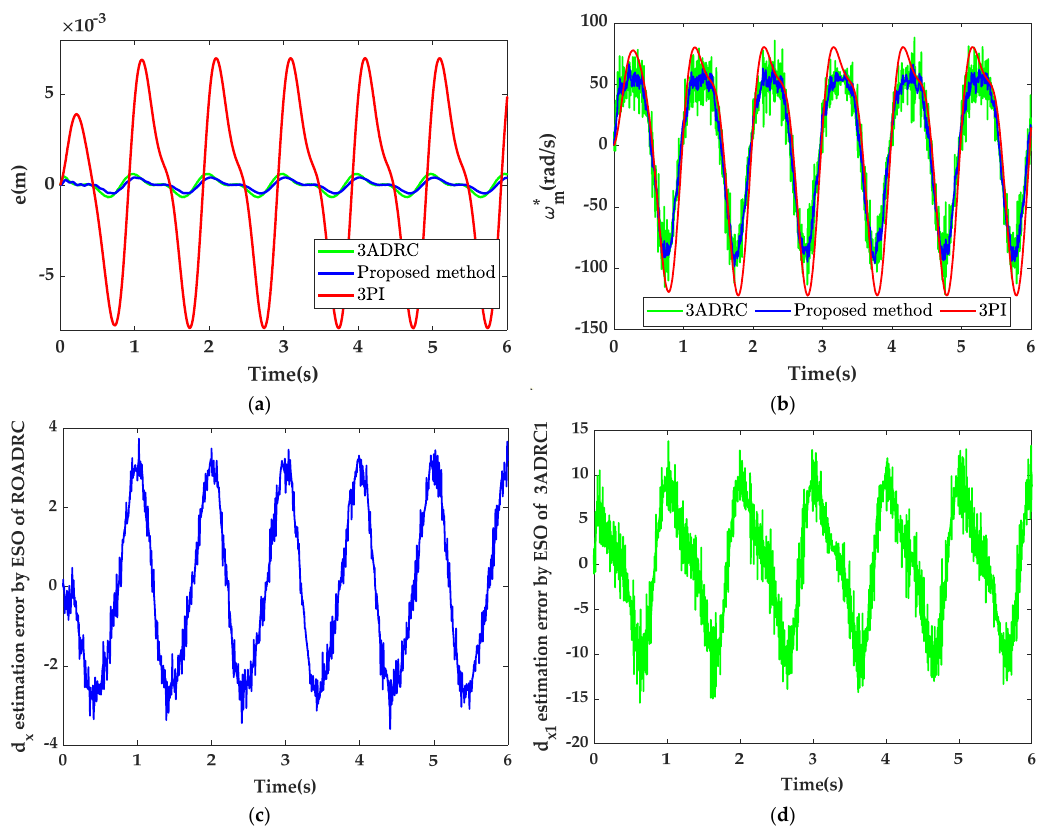
Figure 7. Position time-varying signal response comparison curves under complex disturbance when x d = 0.001 sin (4 π t ) m. ( a ) Comparison curves of position tracking errors of 3ADRC, the proposed method and 3PI; ( b ) control output ω m * response curves; ( c ) disturbance estimation error by ESO of ROADRC; and ( d ) disturbance estimation error by ESO of 3ADRC1.